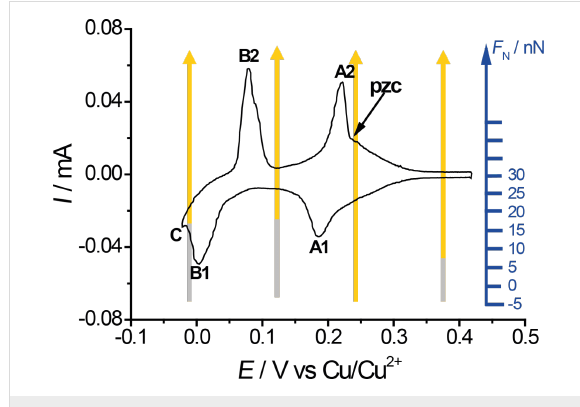
Figure 13: Cyclic voltammogram of Au(111) in 0.05 M H 2 SO 4 + 4 × 10 − 4 M CuSO 4 as shown in Figure 1. Normal force regions of different behaviours are inset as arrows. Orange: atomic-resolution stick–slip; grey: non-stick–slip behaviour.